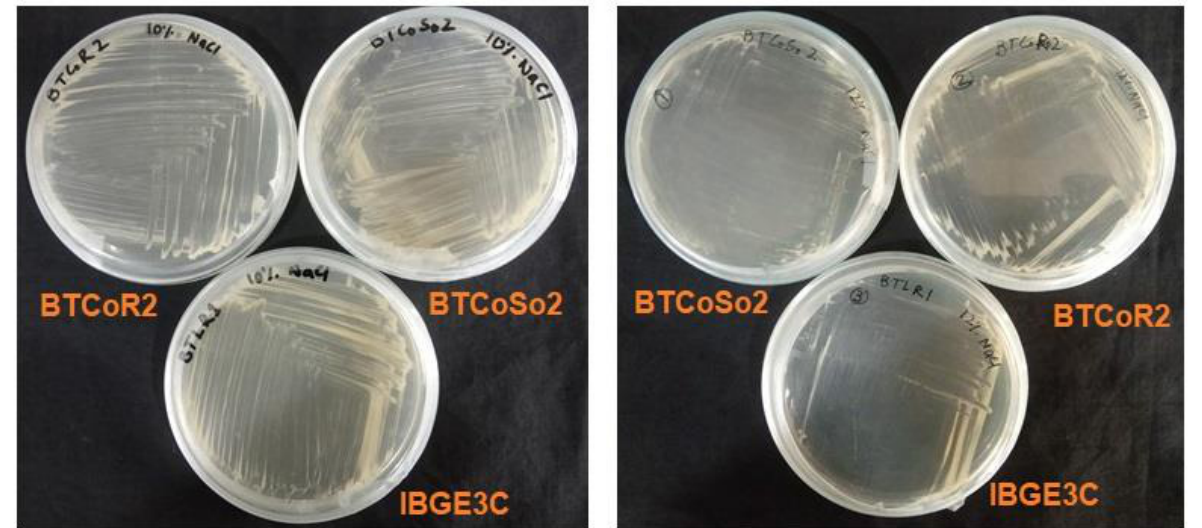
Figure 3. Growth and survival of three potential isolates in nutrient agar medium using higher concentrations of salts including (( Left ) panel) 10% NaCl ( w / v ) and (( Right ) panel) 12% NaCl ( w / v ).